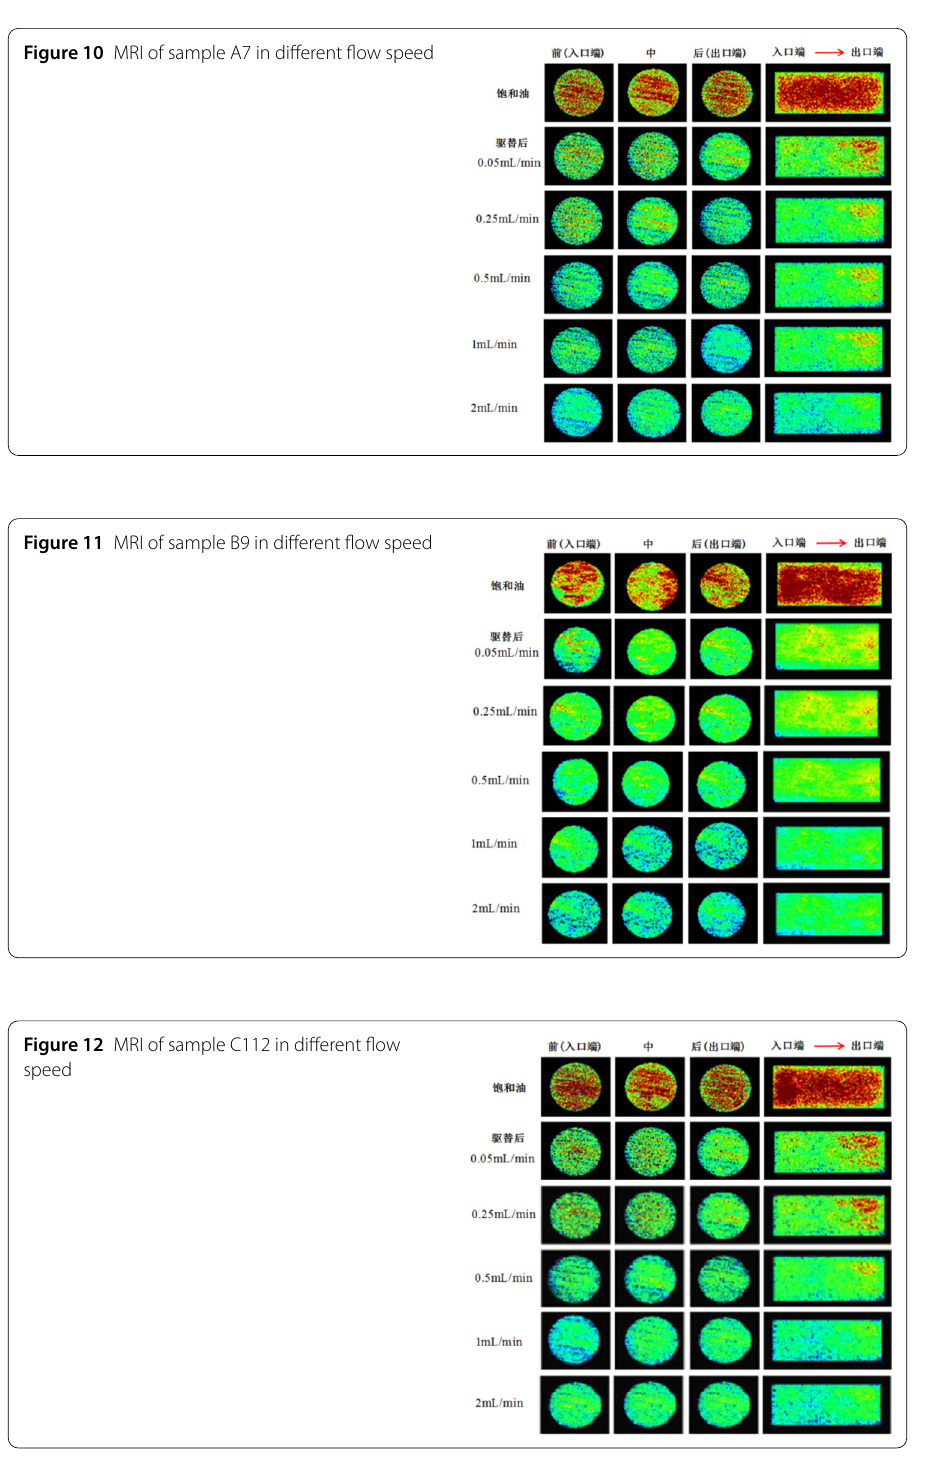
Figure 13 show that the theoretical calculating results of oil saturation is close to the experimental results. The oil saturation variance of sample-A7 is 2.116367, sample-B9 is 3.3992, and sample-C112 is 2.978333. Hence, new method can be used to guide the oilfield